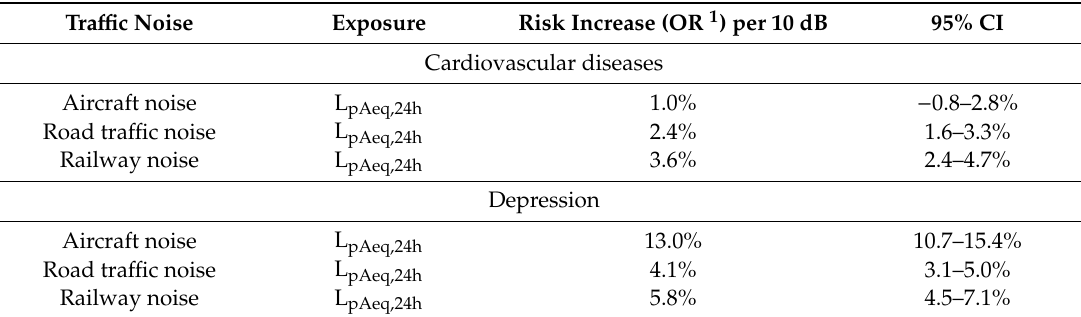
Table 1. Risk increase for cardiovascular increases and depression per 10 dB tra ffi c noise (starting point: 40